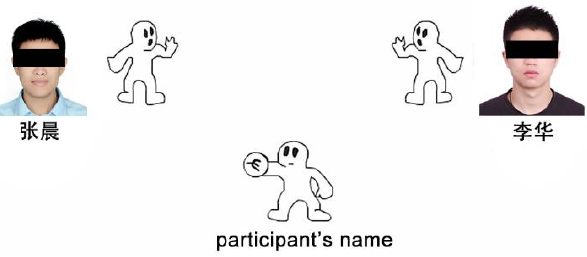
Figure 1. Cyberball game display: Participants are displayed as photographs at the bottom of the screen and the two other players as photographs in the upper corners of the screen. “ 张晨 ” means the Chinese name of Zhang Chen; “ 李华 ” means the Chinese name of Li Hua.